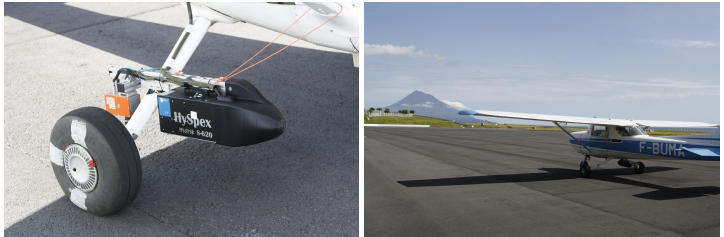
Figure 5. Hyperspectral imaging system mounted in the manned aircraft